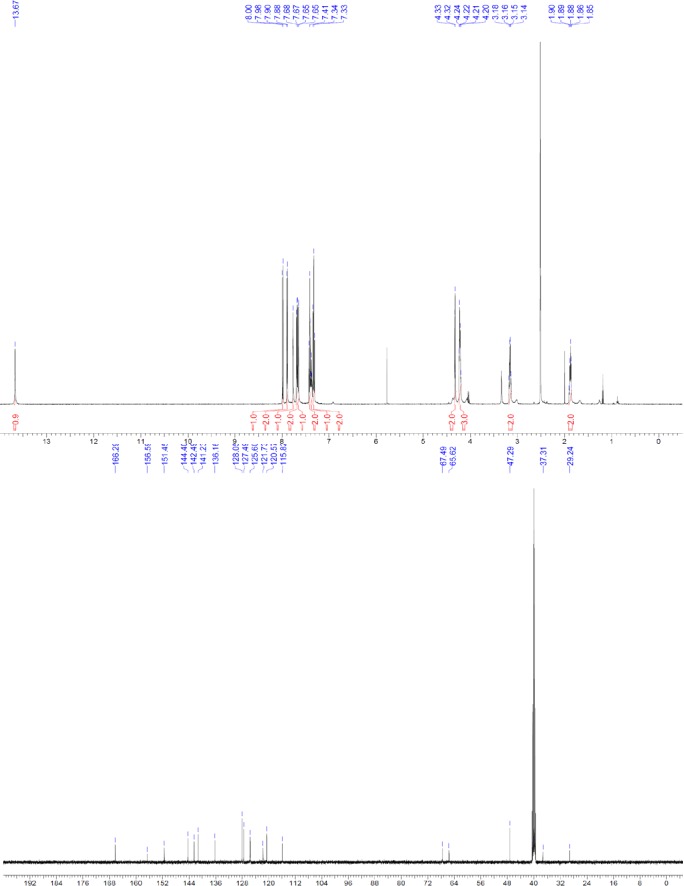
1H and 13C NMR of compound 3i.